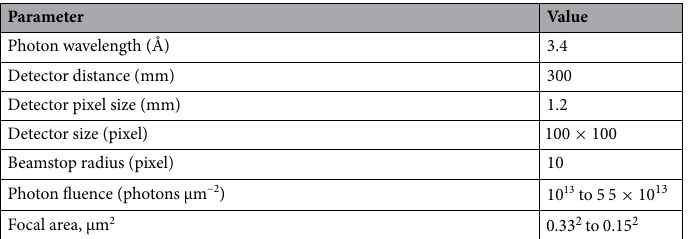
Table 1. Range of parameters used to simulate XFEL-SPI photon patterns of a 105 kDa protein (PDB code, 4ZW6) in this paper. Here we assume that the incident beam energy 3 mJ, transmission efficiency 20%, and a binned detector is used here for computational efficiency.